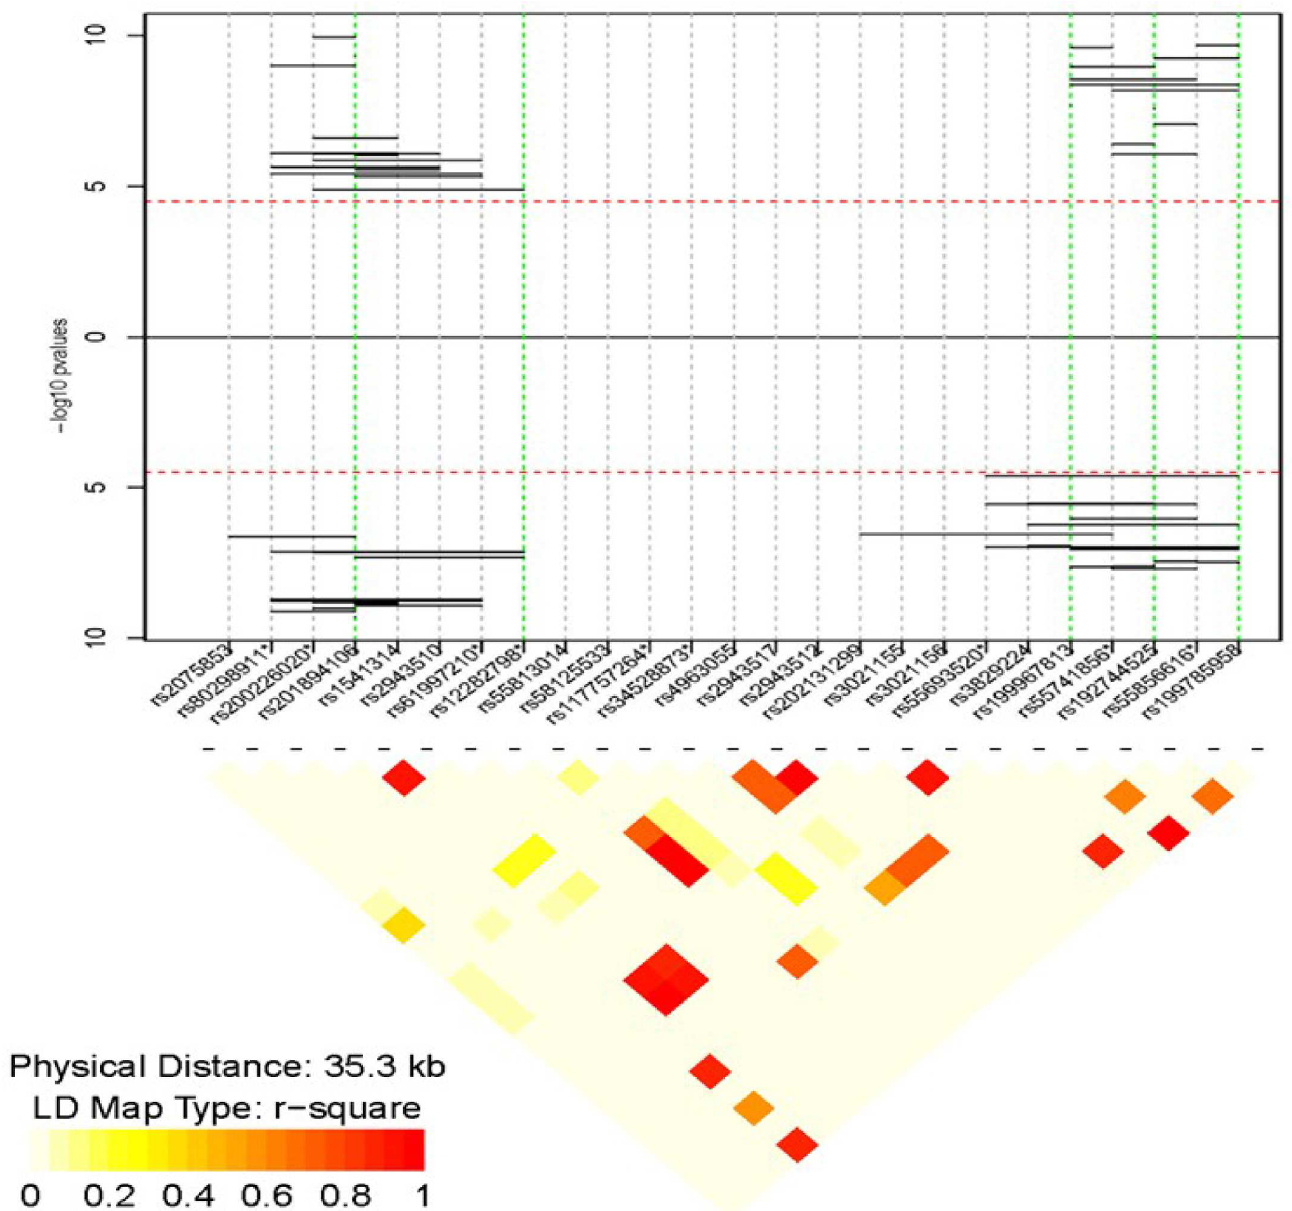
Fig 2. Haplotypes association results across MUC5B . the y axis represents–log 10 (p values) and the x axis shows position within MUC5B . Red dotted lines indicatethe Bonferroni correction level (-log 10 (0.05/1,553)), Points above the line are odds ratio values > 1, and beloware odds ratio values < 1. Green dotted lines indicatethe positionsof significantly associatedSNPs in single SNPs analyses. The “ * ” symbol by the SNP label indicates rare variants (MAF (cid:20) 0.0162). The LD heat map presents pairwise r 2 values within MUC5B based on the CADM study.